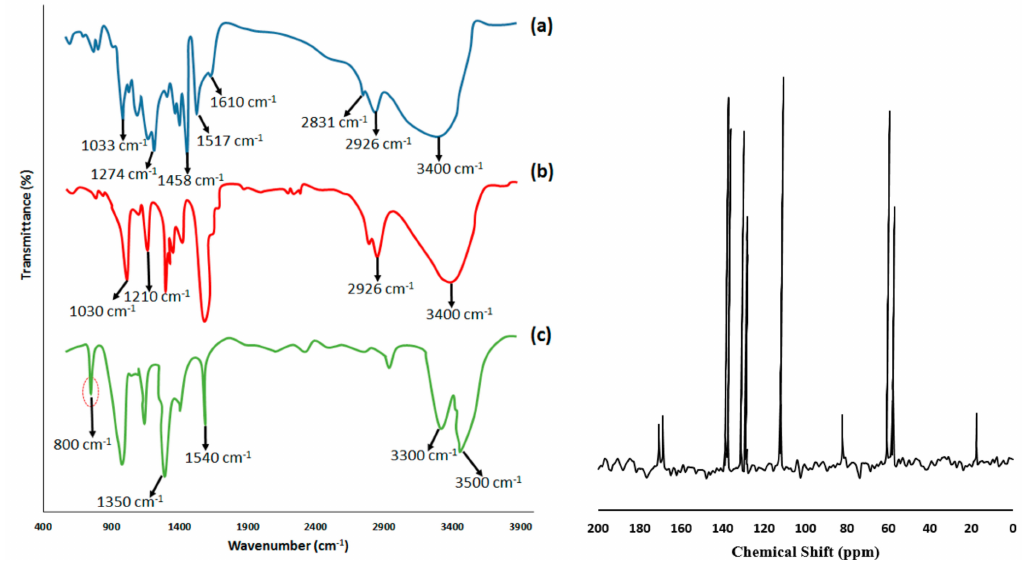
Figure 5. FTIR spectra ( left ) of separated lignin ( a ); demethylated lignin ( b ); and aminated lignin ( c ); 13 C NMR spectrum ( right ) of aminated